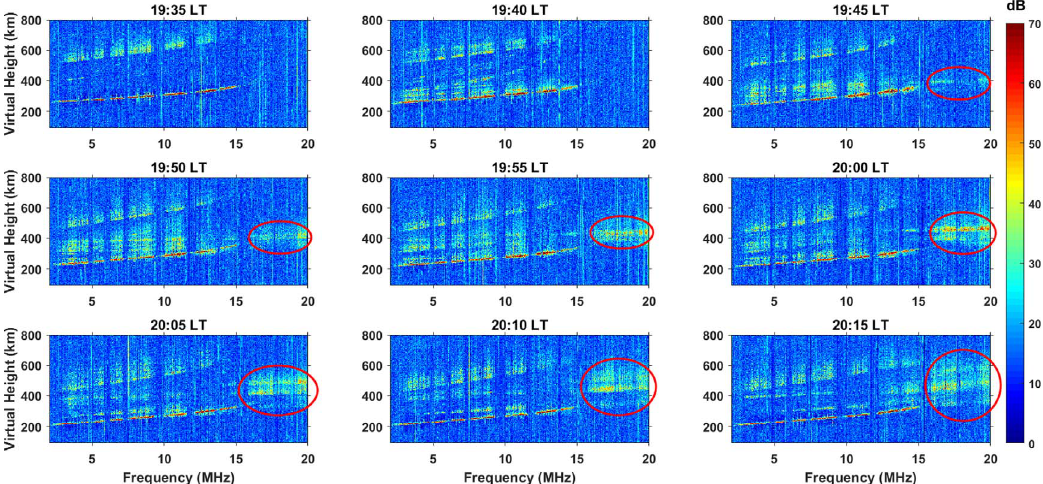
Fig. 2. Evolutions of ionograms (red ellipses represent the backscatter echoes beyond the foF2) recorded at PUR station on 13